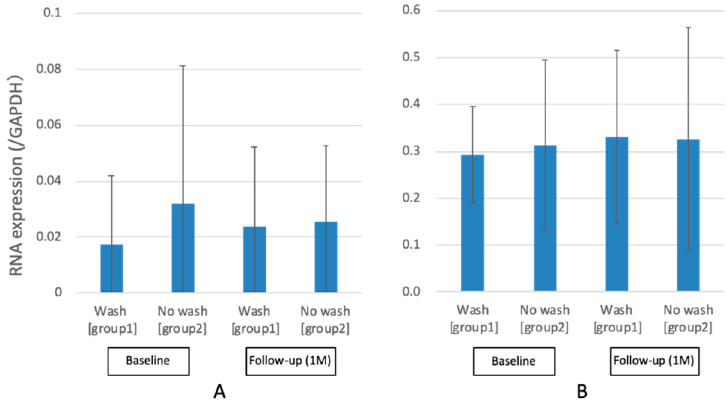
Figure 3. Changes in MUC5AC and MUC16 mRNA expressions. Note the nonsignificant MUC5AC and MUC16 RNA expression level changes between before and after 1 month of eyewash use ( p > 0.05): ( A ) MUC5AC and ( B ) MUC16.